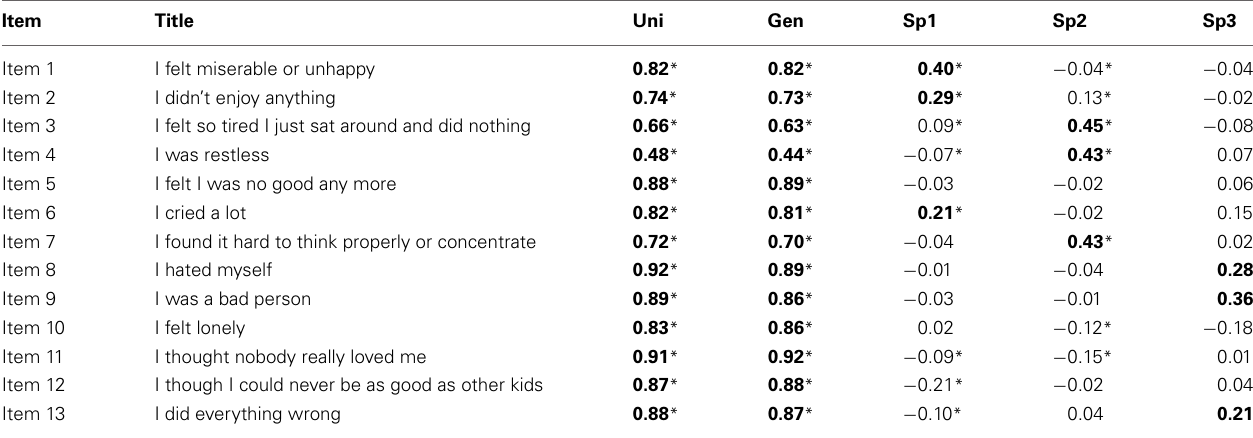
Table 2 | The factor structure of the Norwegian translation of SMFQ: boys.